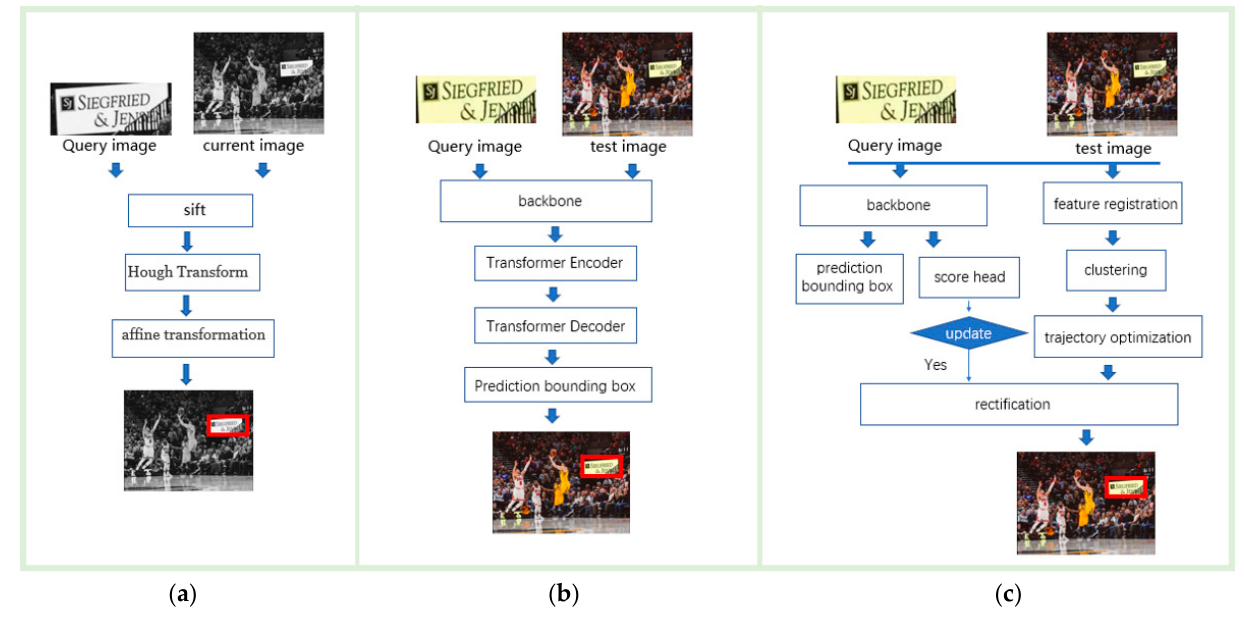
Figure 1. Three di ff erent target localization methods. Figure 1. Three different target localization